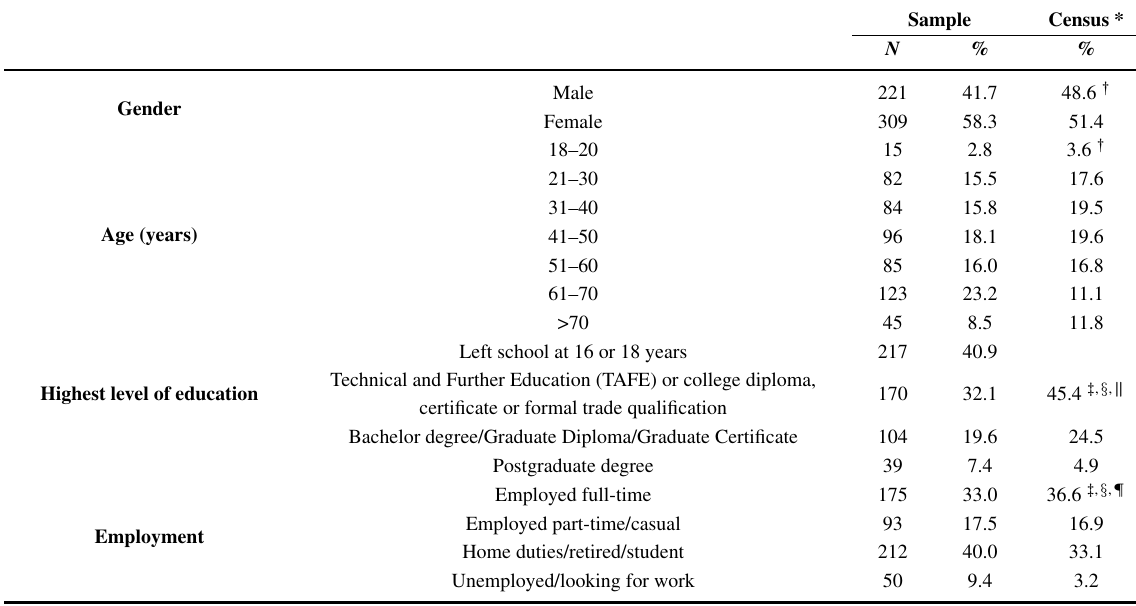
Table 1. Socio-demographic characteristics of the study